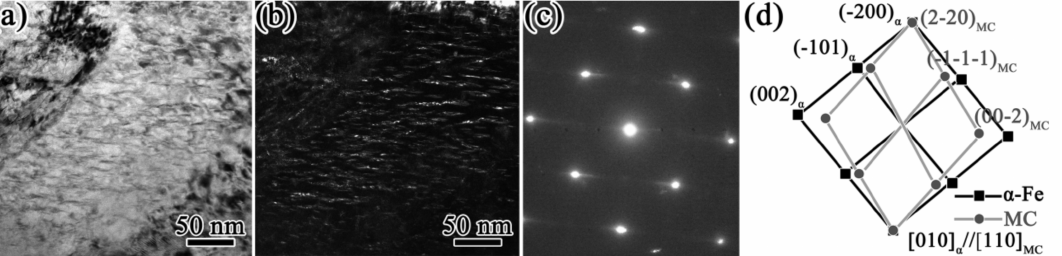
Figure 12. TEM images of granular-like precipitates. ( a ) bright field image; ( b ) dark field image; ( c , d ) diffraction